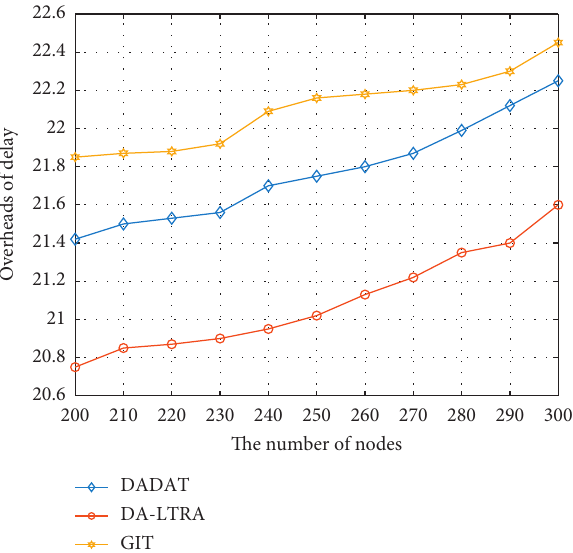
Figure 12: Variance of energy consumption under 300 nodes.